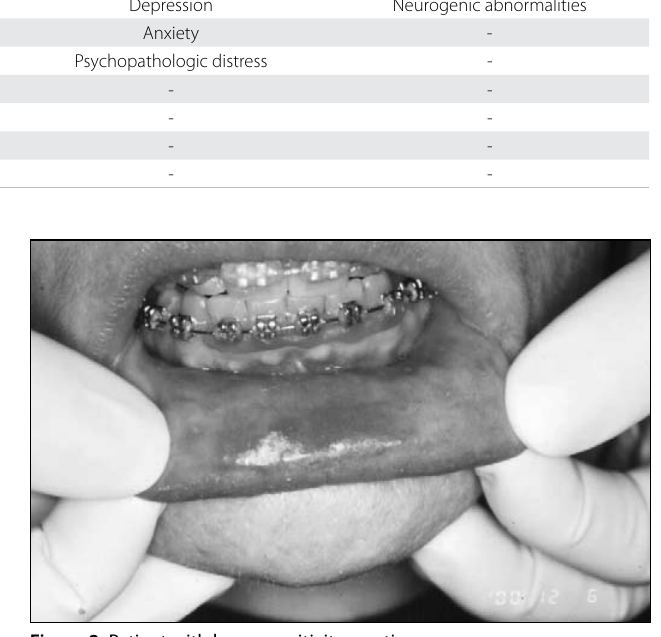
Figure 1. Patient with xerostomia. Figure 2. Patient with hypersensitivity